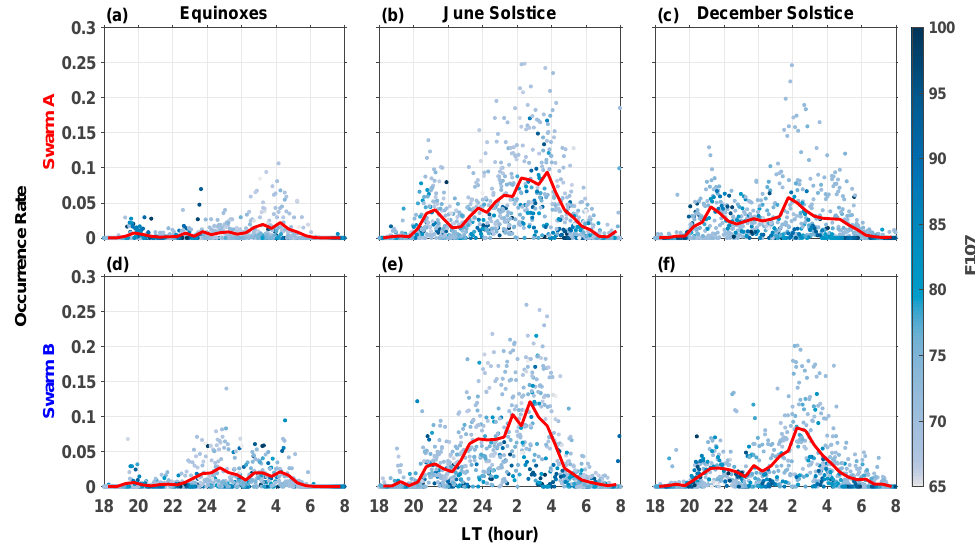
Figure 10. Variations of the plasma irregularity occurrence rate as a function of LT by RODI for different F107 and satellites at midlatitude (±30°–±40° geomagnetic latitudes). The panels from left to right show results during the equinoxes ( a , d ), June solstice ( b , e ), and December solstice ( c , f ), from top to bottom show results for Swarm A and Swarm B. The red lines display the 0.5 h averaged variation of the occurrence. Each dot indicates the average daily occurrence and local time of the satellite’s ascending and descending orbits. To further investigate solar activity dependence, Figure 11 shows the postmidnight occurrence rate calculated by the RODI of midlatitude irregularities with F107. Note that the range of the occurrence rate is 0–0.15 for the equinoxes and 0–0.3 for the solstices. It can be seen that the solar activity dependence of the occurrence rate exhibits negative trends after midnight, and the midlatitude irregularities only have a larger occurrence rate around the solar minimum. Zhong et al. [12] found that the middle-latitudinal band struc- ture became more pronounced as solar activity decreased. The irregularities at middle latitudes exhibited similar solar activity dependence features to the middle-latitudinal band structure. A large number of observations suggested that the occurrence of MSTID at night is inversely correlated with solar activity [14,42], which is consistent with the characteristics of observed midlatitude irregularities in this study. Although many mid- latitude irregularities have been explained by the Perkins instability, the problem with the Perkins instability theory is that the growth rate is too low to produce significant irregu- larities in the F region. Some studies have shown that the occurrence rate of sporadic E layer (Es) instability is higher under low solar activity at nighttime [43], and an electrody- namically coupled E and F region containing Es instability would lead to a faster growth rate of the Perkins instability at middle latitudes [44]. Thus, it can be explained that mid- latitude irregularities are higher under low solar activity.